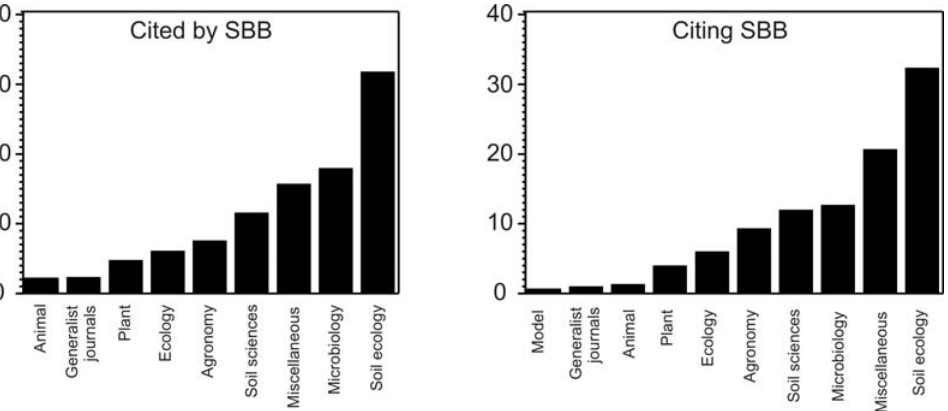
Figure 2. Citation practices in soil ecology. Distribution of articles cited by Soil Biology & Biochemistry (left panel) and citing articles published in Soil Biology and Biochemistry (right panel) according to the category of journal they have been published in. Issues 10, 11 and 12 of the volume 35 (2003) of Soil Biology & Biochemsitry have been scanned in 2007 using the bibliographic data base ISI Web of Science, so that article citing these issues of Soil Biology & Biochemistry have been published between 2003 and 2007 while all the articles cited in these issues have been taken into account whatever their year of publication. Categories of journals are described in the text.